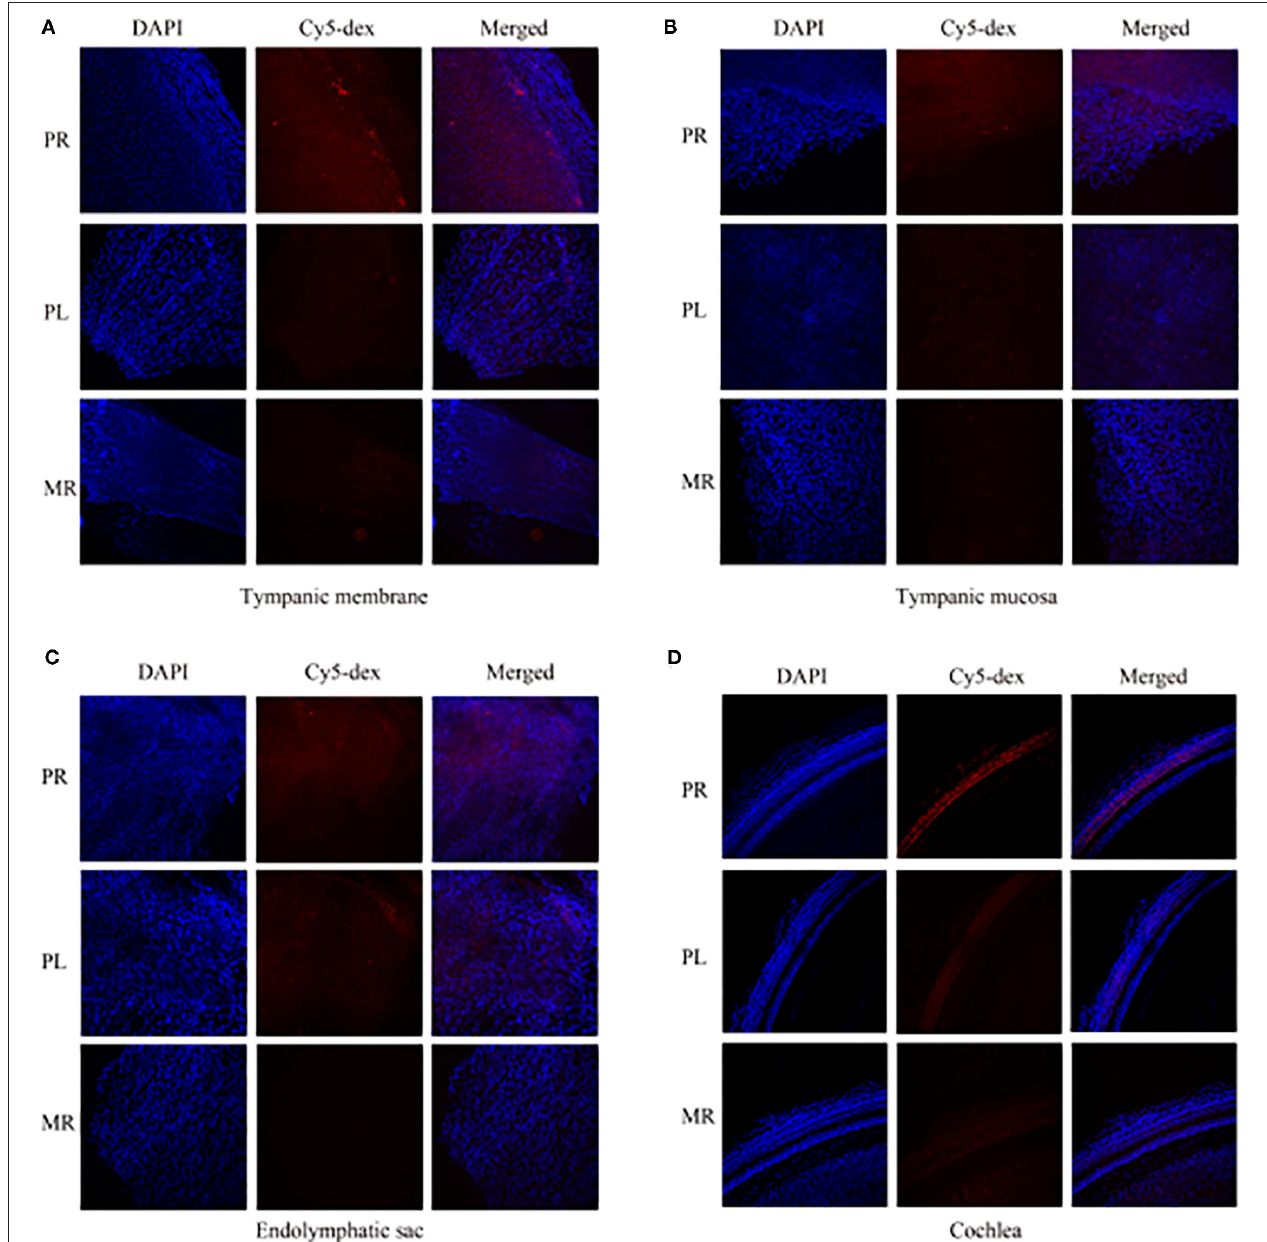
FIGURE 5 | The fluorescent intensities in the tympanic membrane (A) , tympanic mucosa (B) , endolymphatic sac (C) , and cochlea (D) . PR, the right tissue of postauricular injection; PL, the left tissue of postauricular injection; MR, the right tissue of intramuscular injection.